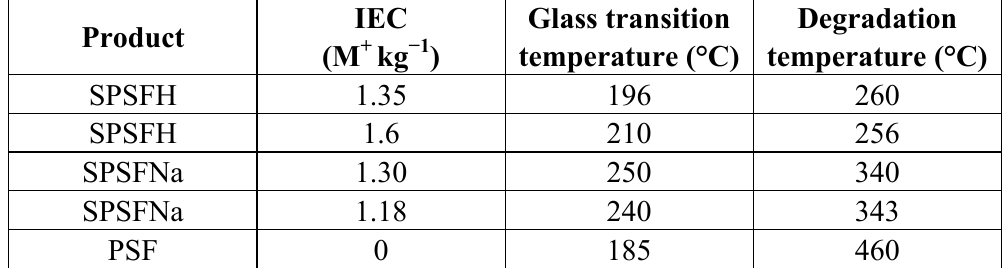
Table 1. Glass transition temperature measured by modulated differential scanning calorimetry (DSC) and degradation temperature measured by thermogravimetric analysis (TGA) of sulfonated polysulfones. IEC: ionic exchange